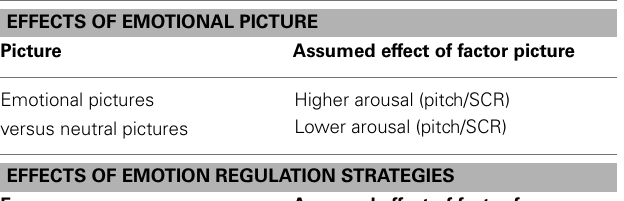
Table 1 | Expected results (effects of emotional picture and emotion regulation strategies) on pitch and